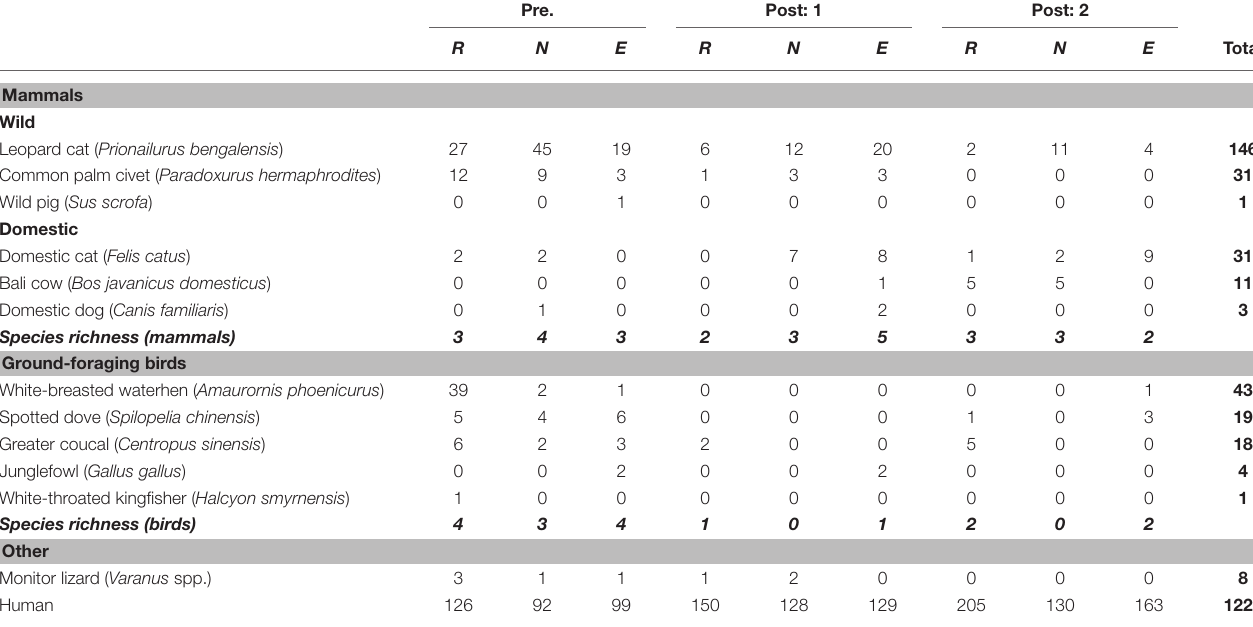
TABLE 1 | Species abundance and richness by treatment and time period. Pre. Post: 1 Post: 2